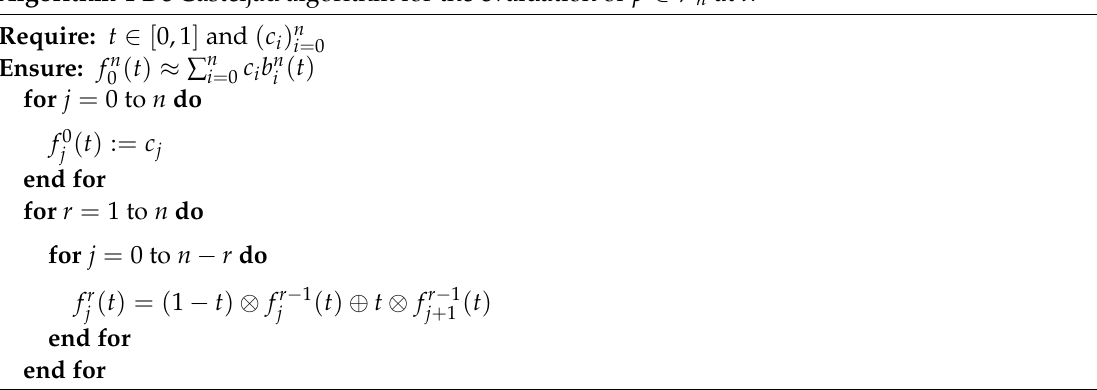
Algorithm 4 De Casteljau algorithm for the evaluation of p ∈ P n at t